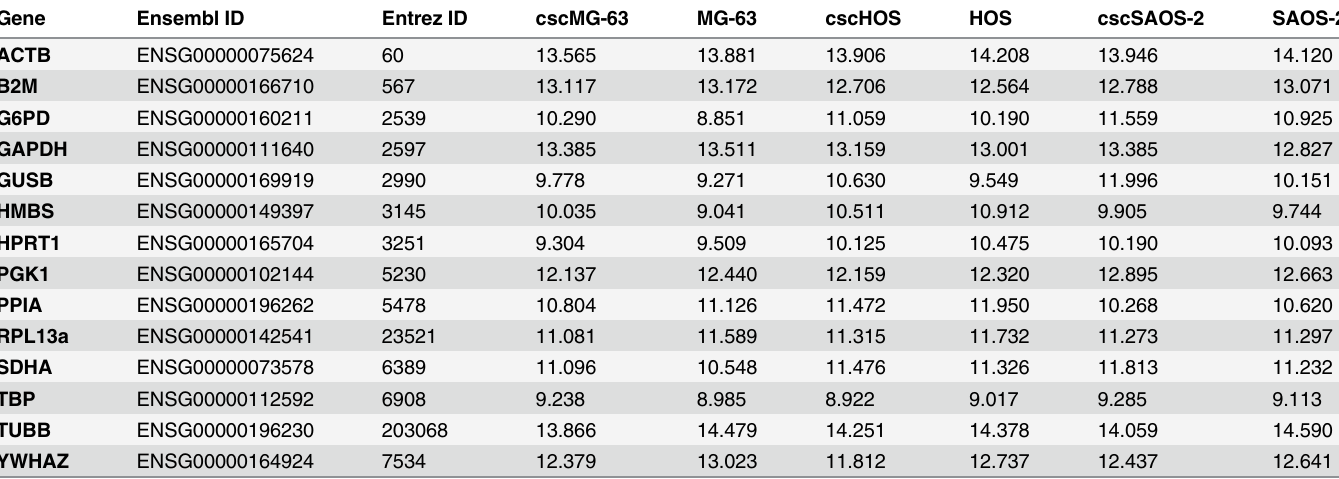
Table 2. Transcriptome data from deep sequencing analysis of CSC and native cells of